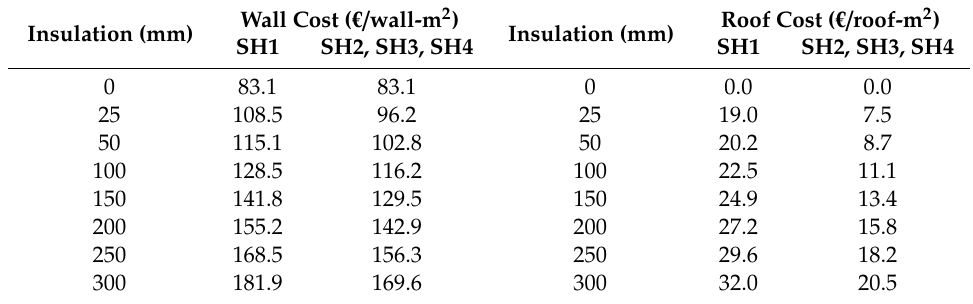
Table 4. Cost of improving the thermal insulation level of the building envelope. [56].